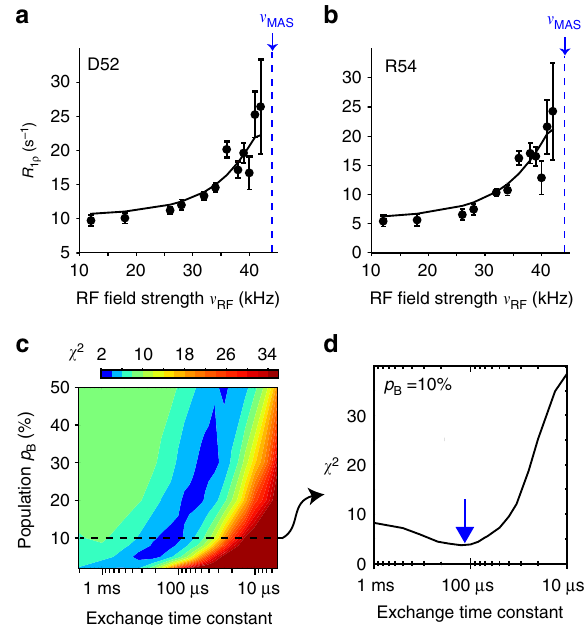
Fig. 2 Angular motion in the β -turn of MPD-ub crystals probed by NERRD NMR. a , b NERRD dispersion data of the two amide sites in MPD-ub that are adjacent to the fl ipping peptide plane D52/G53, recorded at 44.053 kHz MAS frequency. Error bars of R 1 ρ values were obtained by standard Monte Carlo analyses, described in the Methods section. Solid lines show fi t curves from a two-site jump model that assumes that the minor conformation has a population of p B = 10%. c χ 2 surface of a grid-search of simulated NERRD curves against the experimental data in a , b . Hereby, a common minor-state population p B and exchange correlation time τ = 1/( k ex AB + k BA ) were assumed for the two residues, and the jump angle was separately fi tted for each residue. More details of this NERRD fi t are reported in Supplementary Fig. 4. d Cross-section across the χ 2 surface along the τ ex dimension corresponding to a minor-state population of